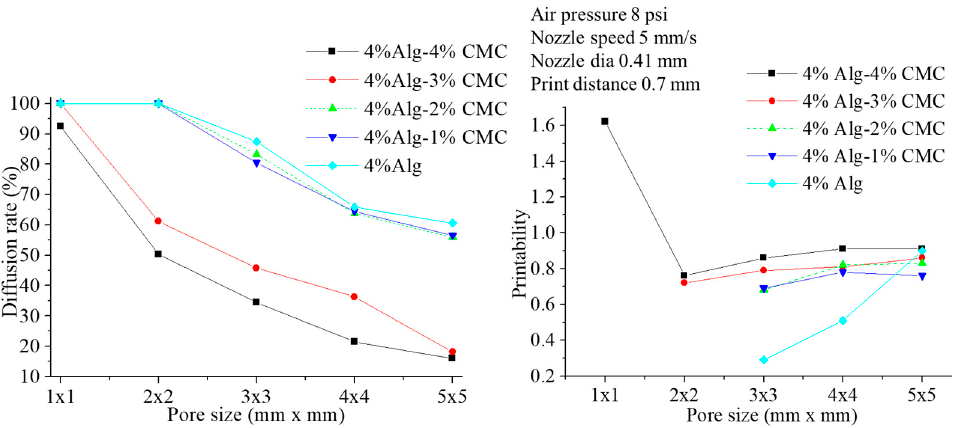
Figure 11. Diffusion rate and printability in filament fusion test.